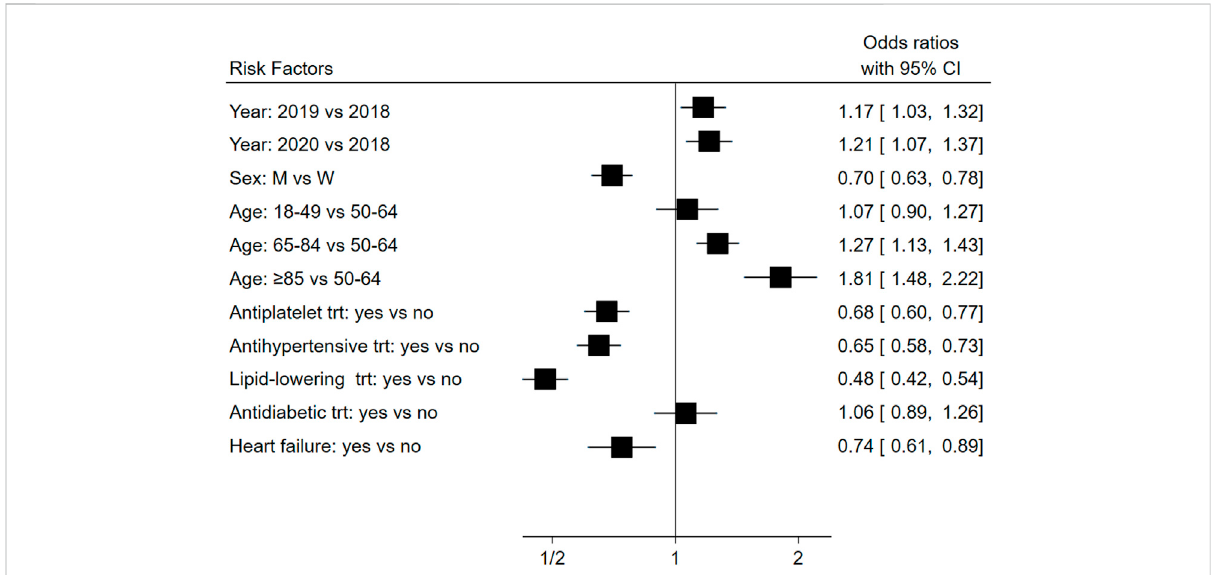
FIGURE 2 Association between several individuals ’ covariates and the risk of not receiving a post-infarction beta-blocker therapy. *trt, treatment; CI, con fi dence